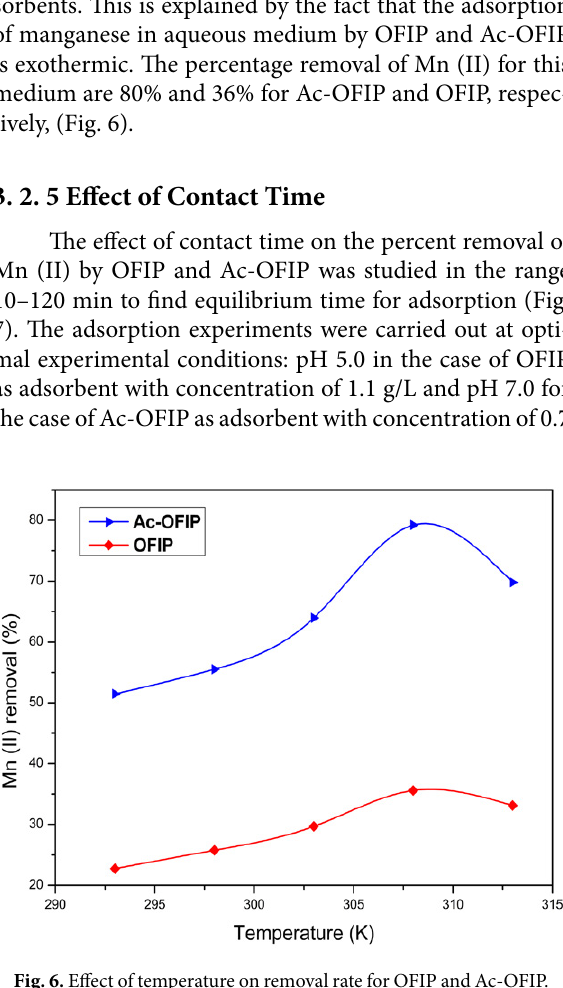
Fig. 6. Effect of temperature on removal rate for OFIP and